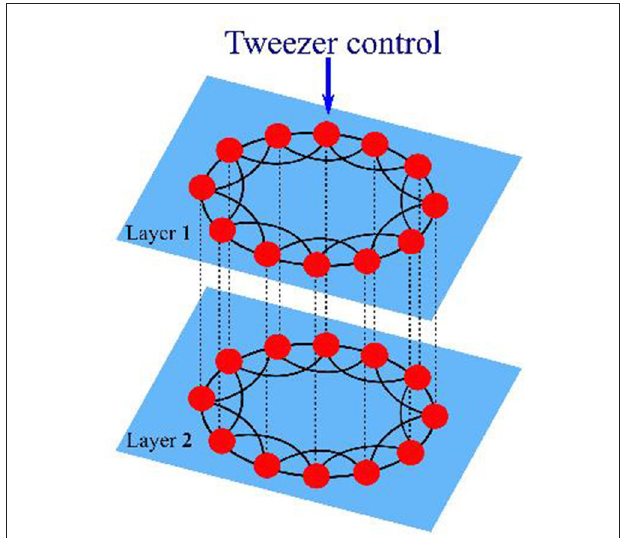
FIGURE 1 | Schematic structure of the two layer networks: red dots denote the oscillators, blue planes correspond to the two layers. Solid lines show intra-layer couplings, dashed lines represent pairwise inter-layer couplings between the oscillators. Tweezer control is applied to layer 1.